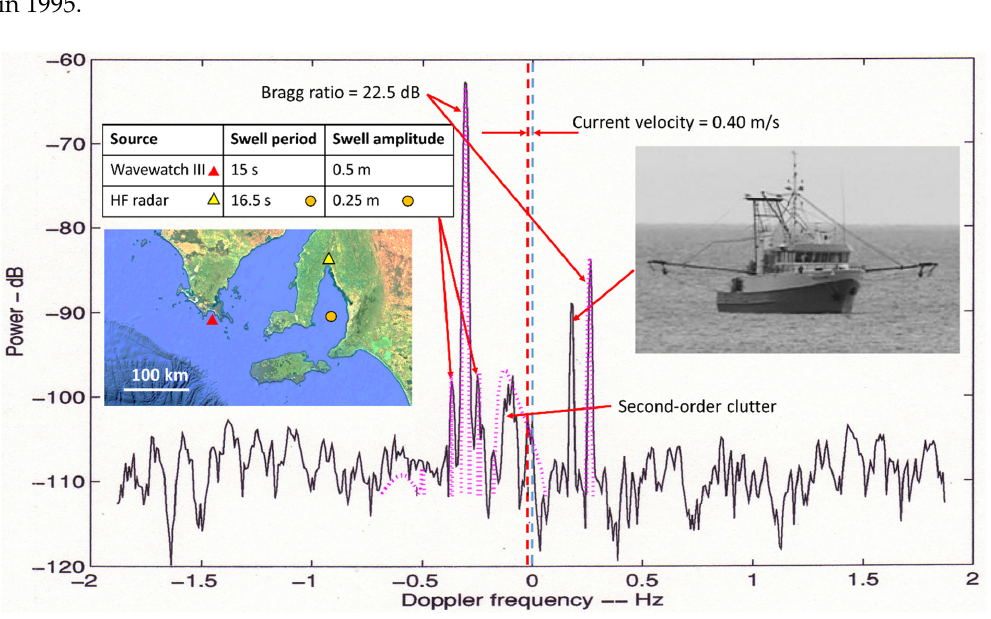
Figure 8. The Doppler spectrum recorded from a resolution cell at a range of 150 km. The frequency offset due to the radial component V of an ocean current is indicated by the inequality of the dis- placements ∆ (cid:3019) and ∆ (cid:3002) of the Bragg lines from zero Doppler. The black solid line shows the radar measurement, while the dotted line is a theoretical model fitted to the data.